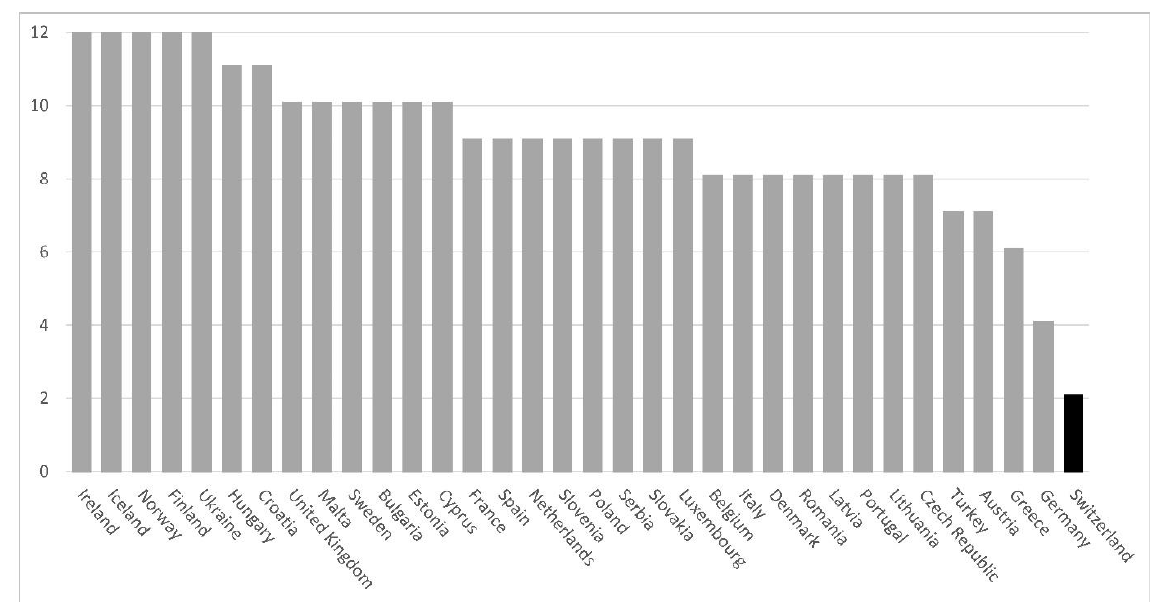
Figure 4: European countries ranked by TCS score for advertising bans. Source: Tobacco Control Scale in Europe 2013